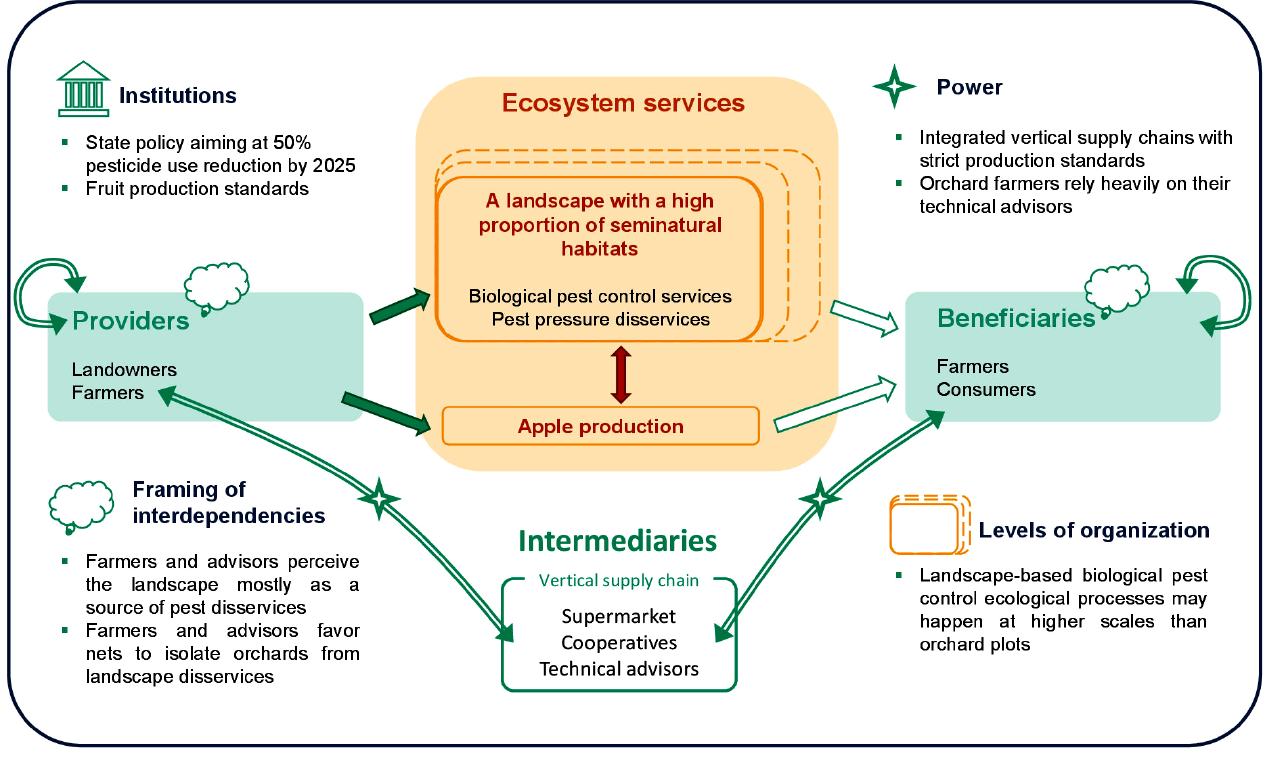
Fig. 3 . Example of a potential action arena on the issue of biological pest control in an apple production area in southwest